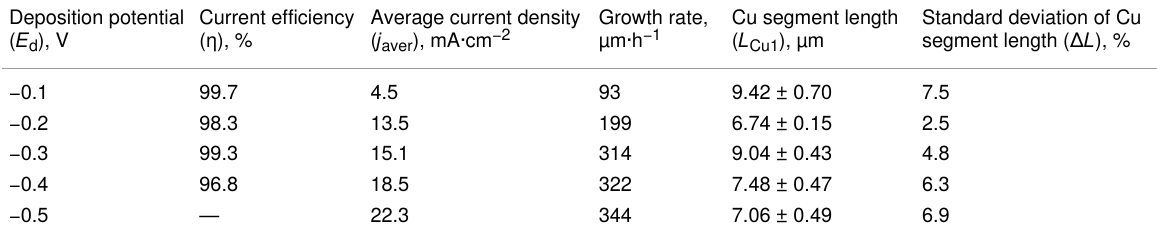
Table 1: Parameters for the first Cu segment